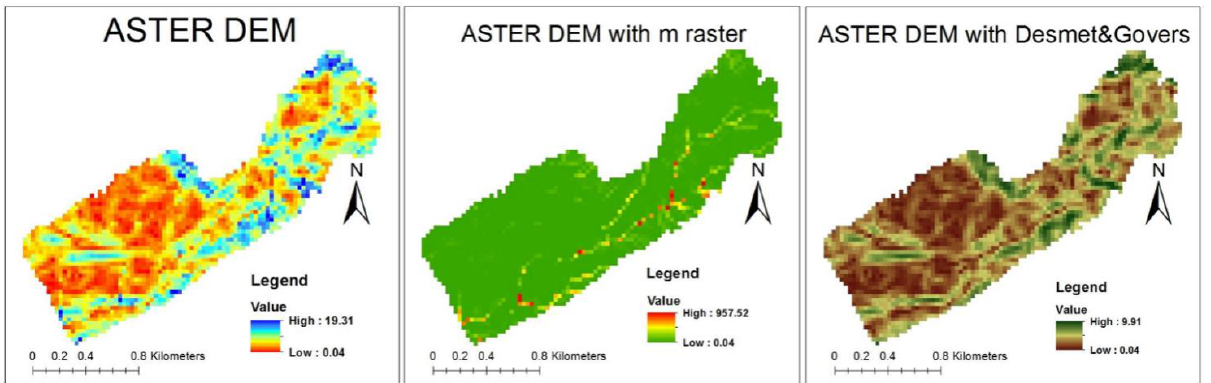
Figure 4: LS factor of ASTER DEM with constant slope exponent, spatially distributed slope exponent and with multiple flow